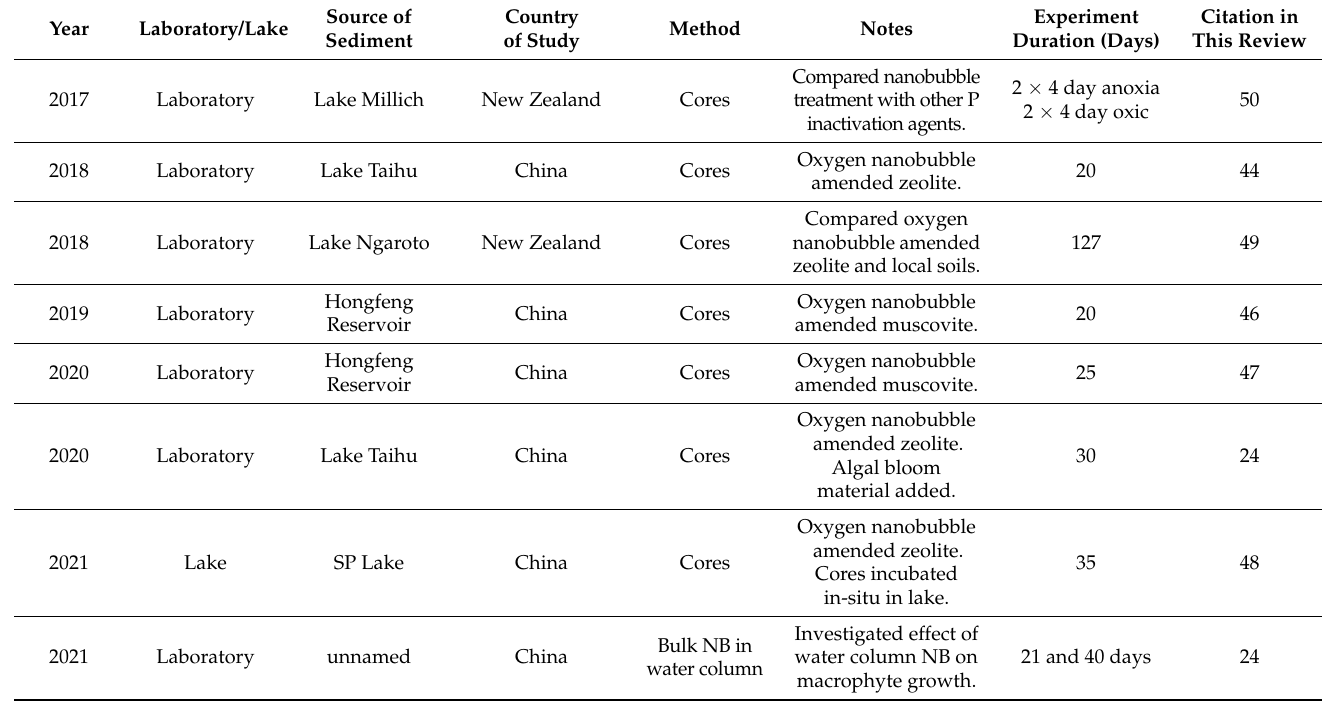
Table 1. Studies reviewed here which directly investigate the use of oxygen nanobubbles in the restoration of lake eutrophication. (NB, oxygen